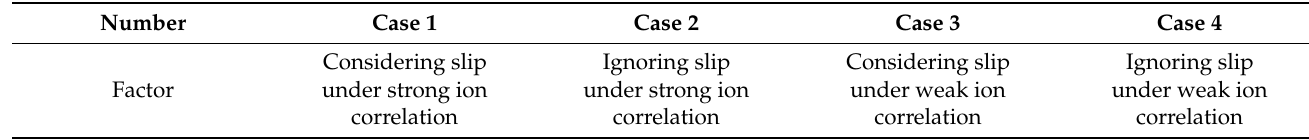
Figure 11. The influence of the ratio of HD C-S-H on molar flux of water at steady state. Table 4. Factors considered in different